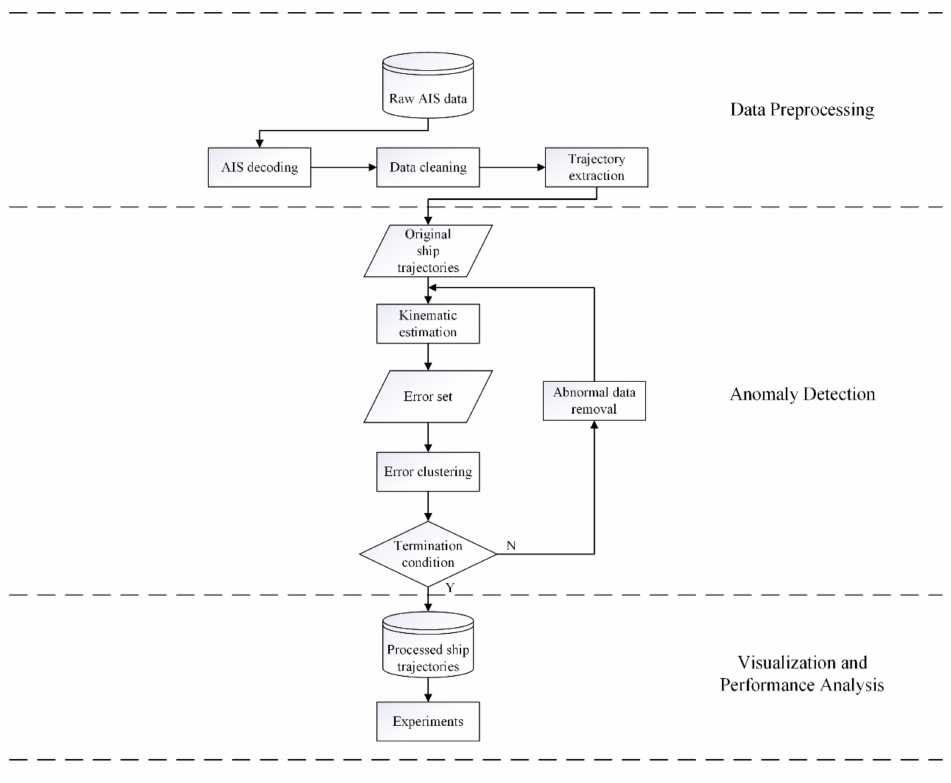
Figure 1. Research methodology. Table 1. Example of correct trajectory data.